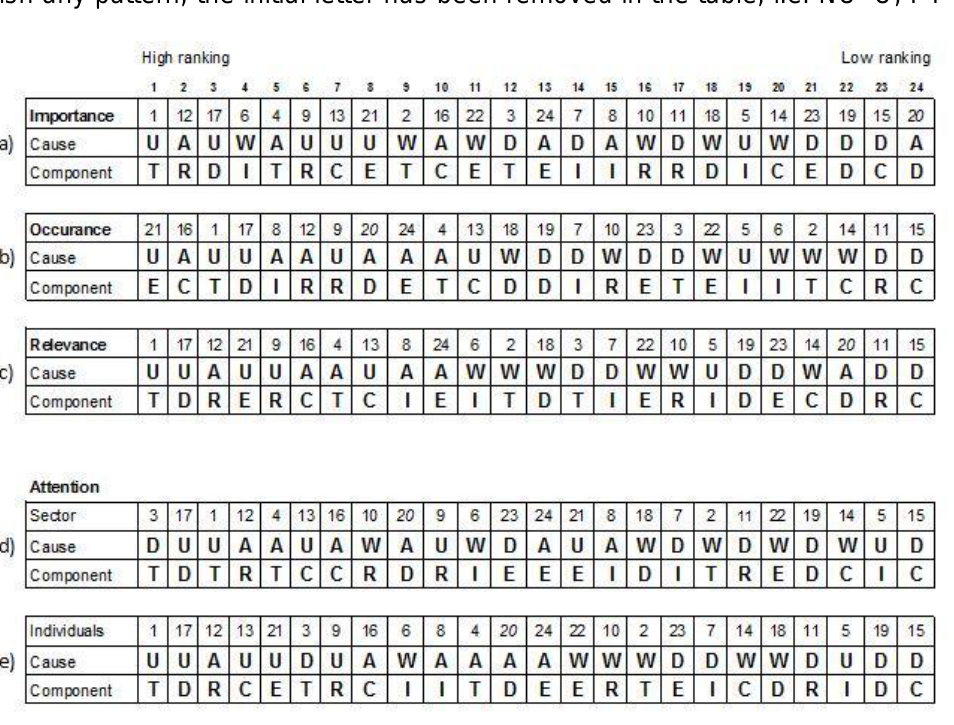
Table 6 Coding regarding cause for inadequate behaviour and situational problem component. In order to make it easier to discern any pattern just the distinguishing letter for cause and problem component is used so that e.g. U=NU=do not understand and